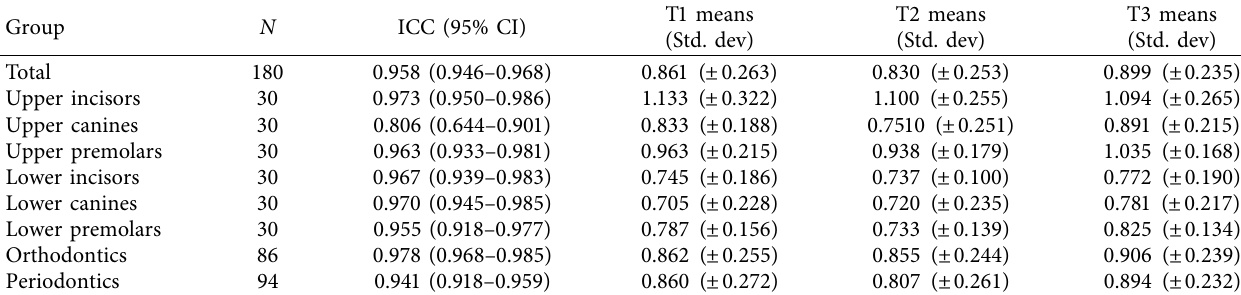
Table 6: Interrater GT by tooth groups and clinic